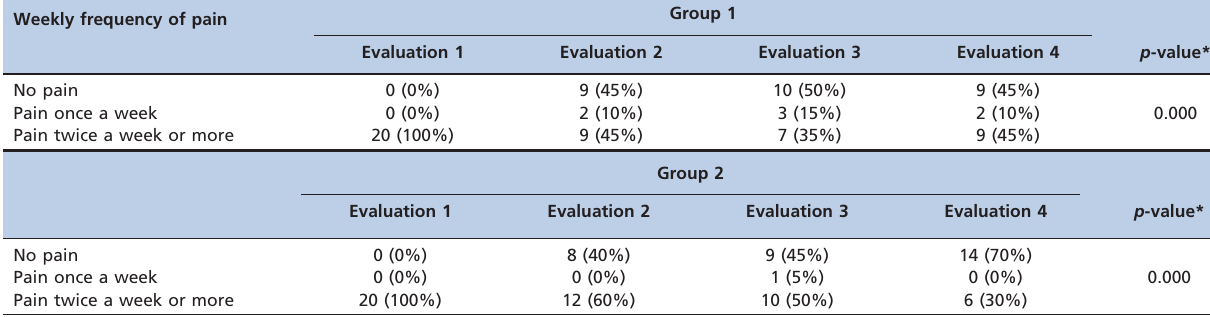
Table 1 - Distribution of weekly periodicity of pain symptoms in groups 1 and 2 before and after the treatment (immediately, three months and one year after the treatment).